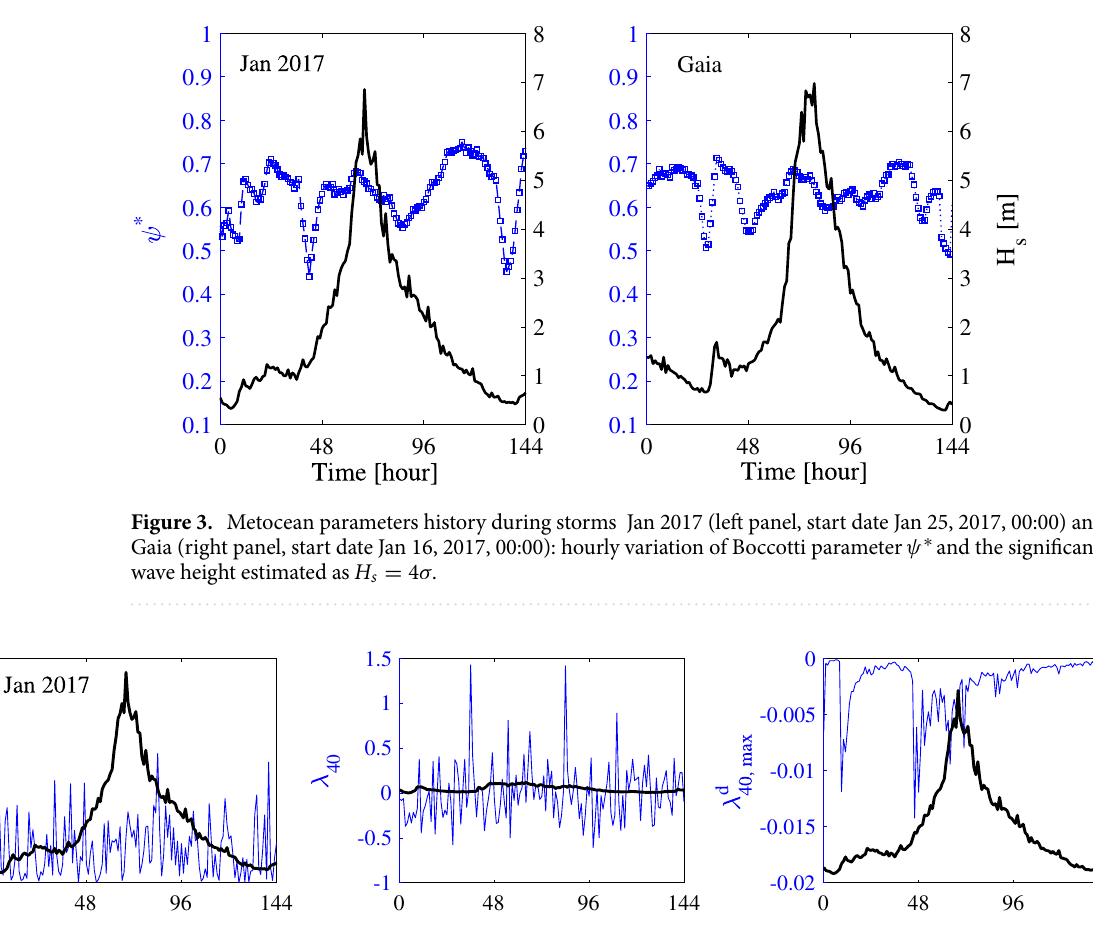
(cid:31) 3 / 3 (thin blue line), =